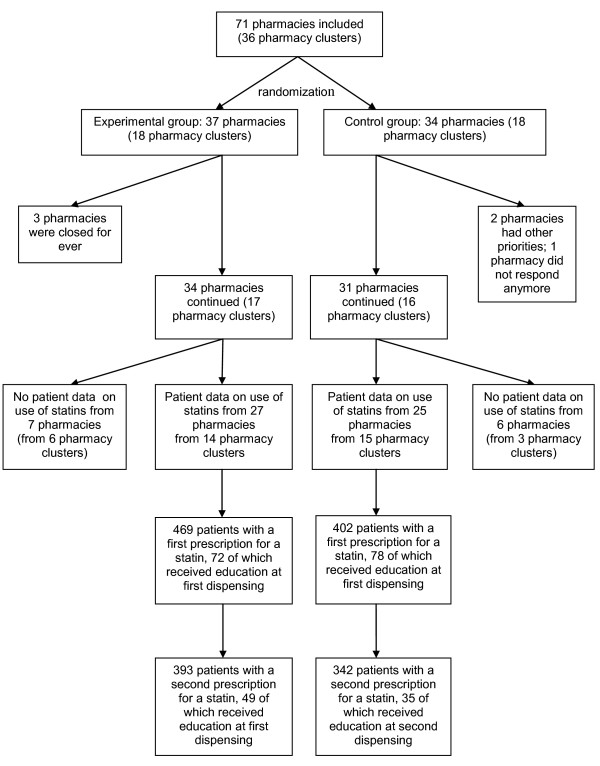
Participant flow.